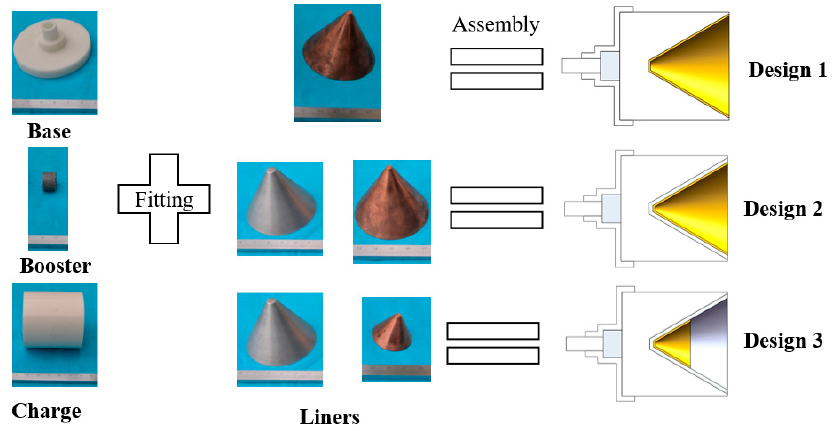
Figure 4. Configuration of the three designs. Table 1. Experimental conditions.